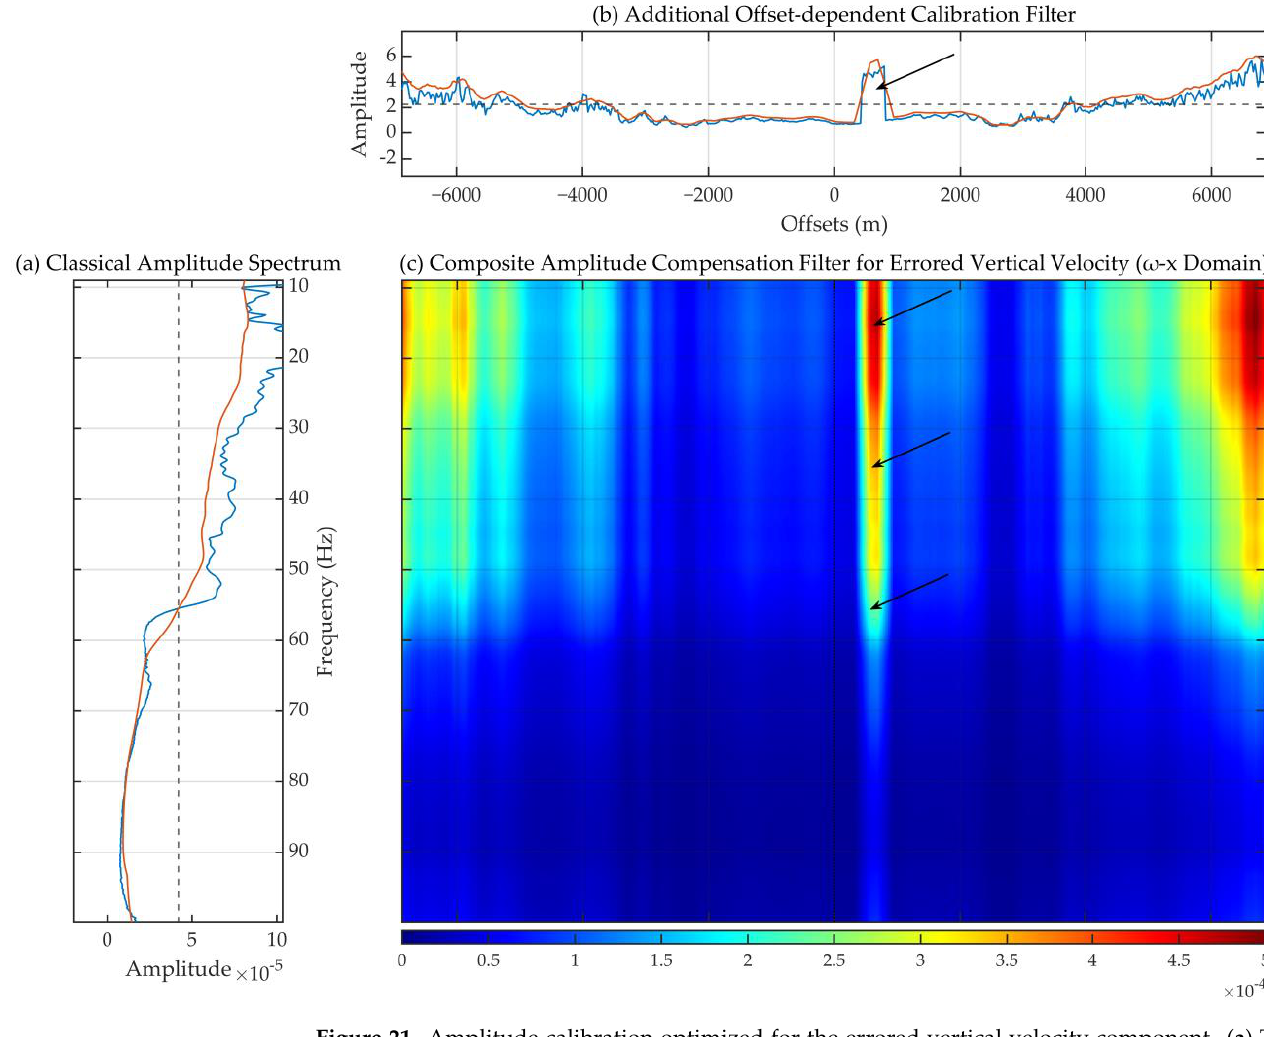
Figure 21. Amplitude calibration optimized for the errored vertical velocity component. ( a ) The classical-type frequency-dependent amplitude calibration filter optimized following traditional methods. ( b ) The additional calibration along the offset axis introduced after applying classical calibration by our novel method. ( c ) The composite amplitude compensation filter (i.e., the full amplitude spectrum of composite calibration filter) for errored vertical velocity. The corresponding responses of the horizontal and composite calibration filters to the deliberately introduced errors are indicated by the arrows. Blue curve — optimized operator, orange curves — calculated curve.